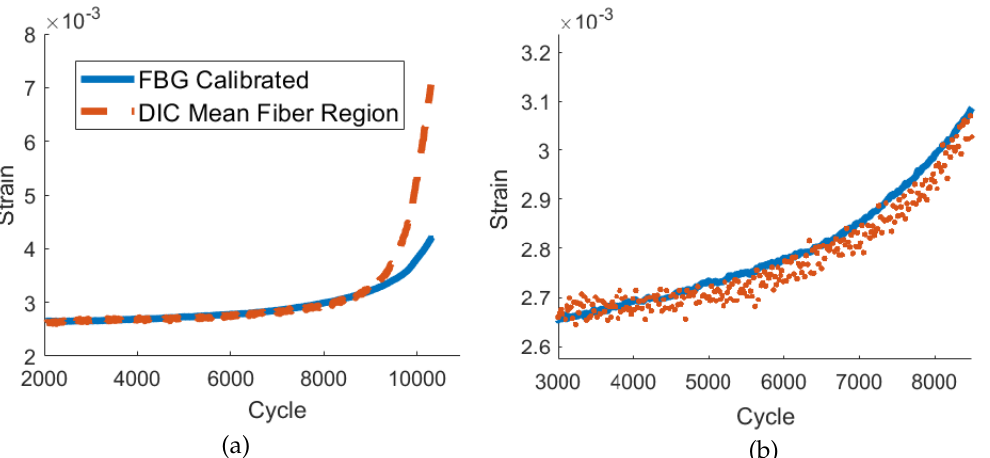
Figure 10. Vertical strain measurements from an FBG sensor UAM-embedded into a CT specimen and average strain from DIC in the region of the FBG; ( a ) from the end of the pre-cracking phase ( ∼ cycle 2000) to sample failure ( ∼ cycle 10500); ( b ) detailed view of (a) from approximately cycle 3000 to